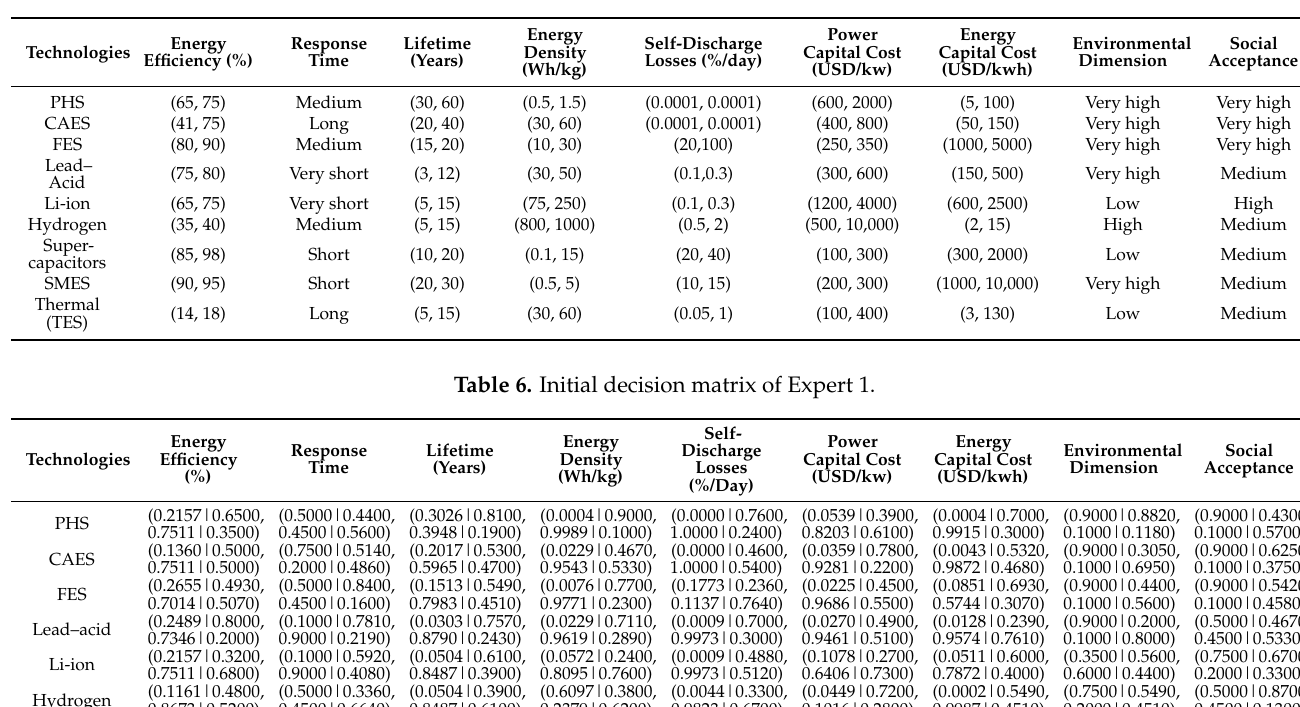
Table 5. Decision basic data of Expert 1.